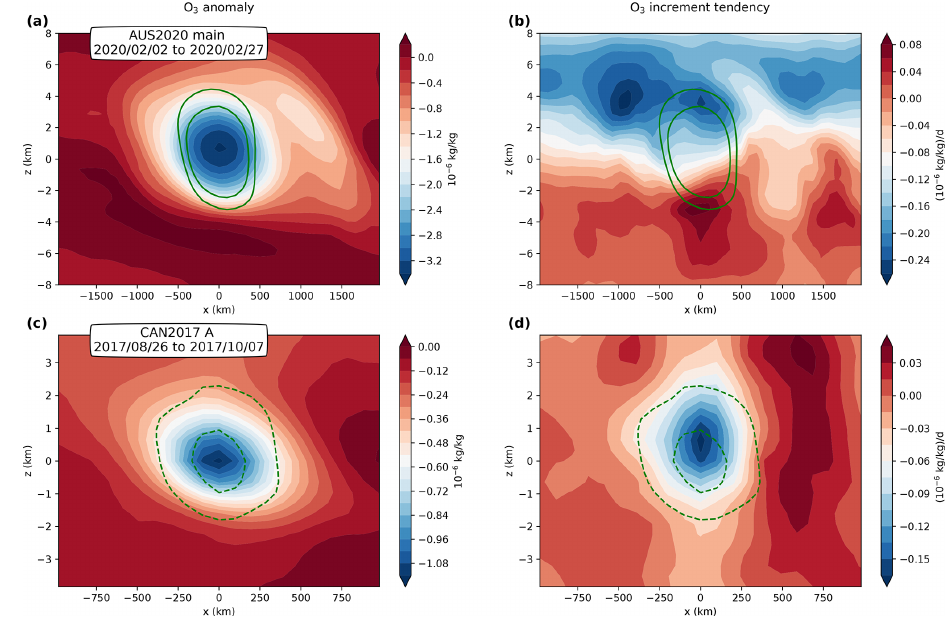
Figure 11. Same as Fig. 9 but for ozone anomalies from the zonal mean (a, c) and ozone increments (b, d)